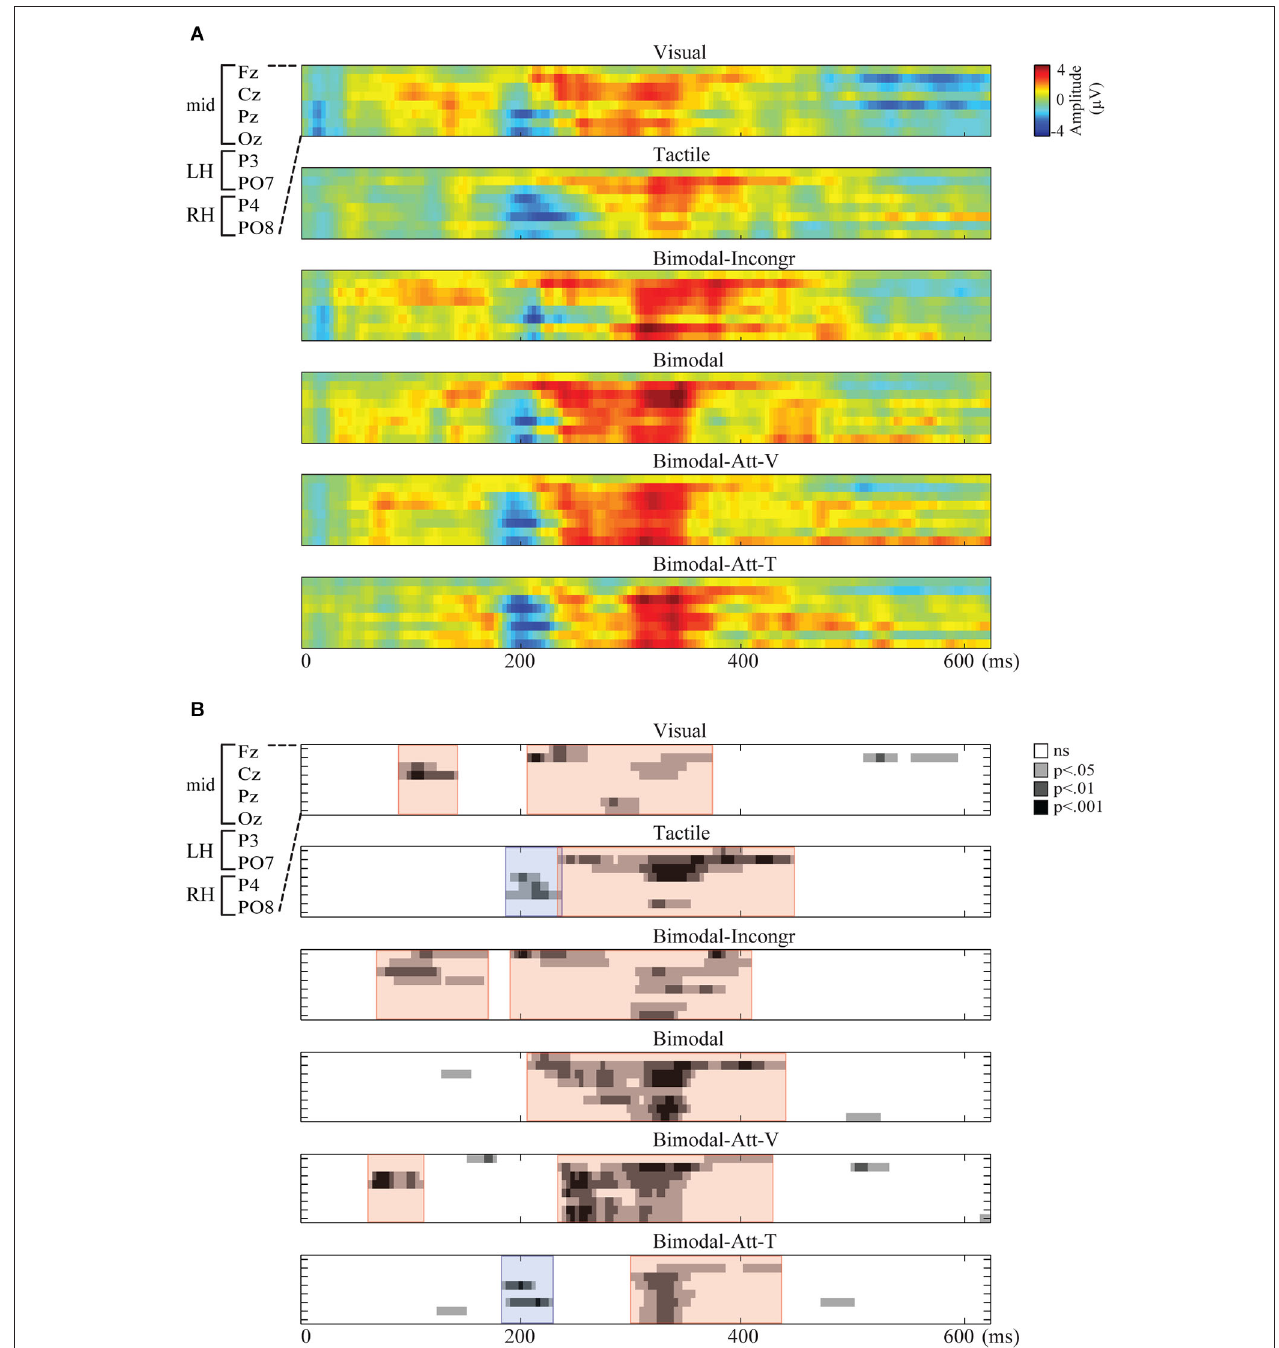
condition. (B) The statistical significance of the endogenous ERP ( p -values) resulting in stable segments, clustered in ERP components. ERP components are marked by colored overlays in red and blue for positive and negative components,